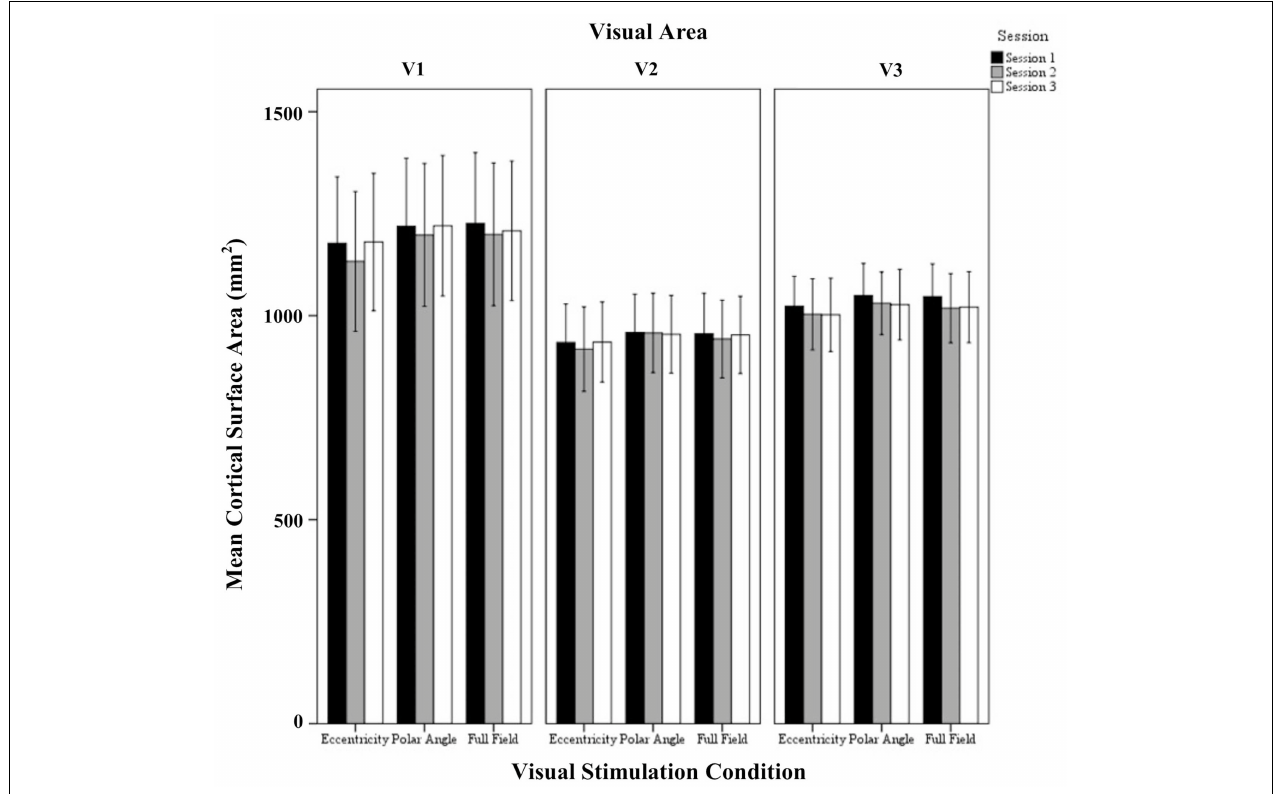
FIGURE 2 | Quantitative comparison of activated cortical surface area (mean ± SEM) across sessions in V1, V2, and V3 for all visual stimulation conditions. Significant effects were observed for the factors session and visual area as detailed in Results.